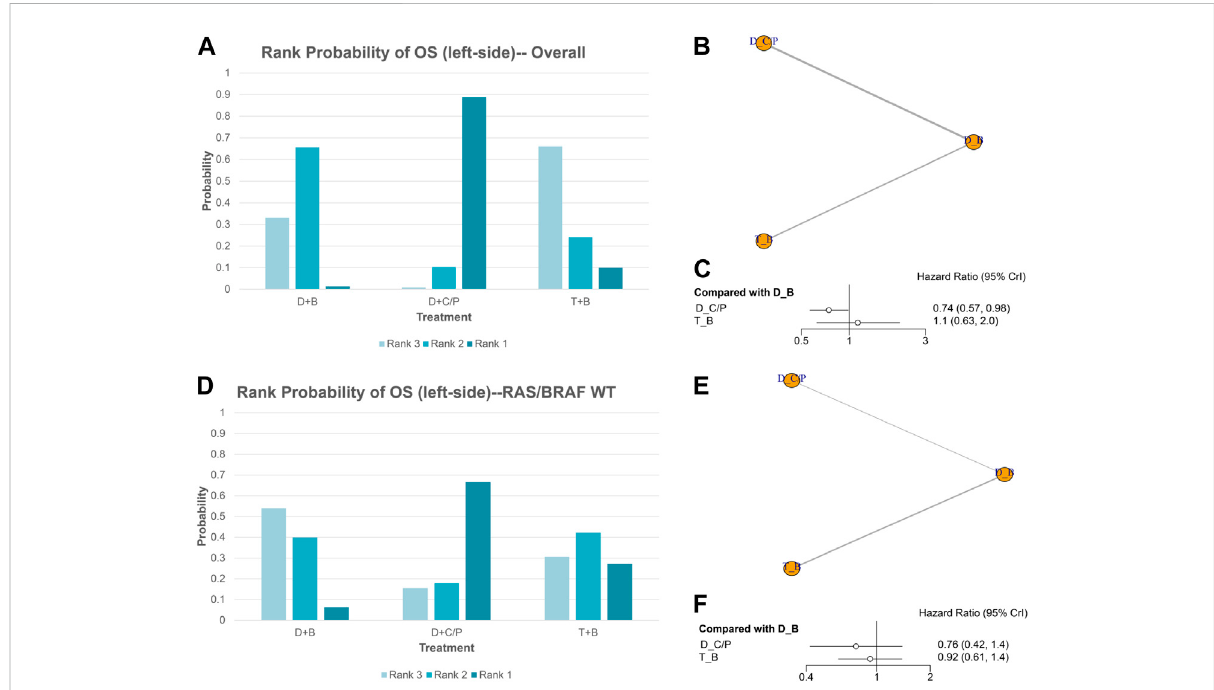
FIGURE 1 Overall survival (OS) in overall and the subgroup of RAS/BRAF wild-type patients. Overall: (A) The rank probability of the bene fi ts of the treatments. (B) Network of eligible comparisons for network meta-analysis. (C) Forest plot of comparisons to double-drug regimen plus bevacizumab. RAS/BRAF WT: (D) The rank probability of the bene fi ts of the treatments. (E) Network of eligible comparisons for network meta- analysis. (F) Forest plot of comparisons to double-drug regimen plus bevacizumab. ( N = 1925, B: bevacizumab; C: cetuximab; D: double-drug; P: panitumumab; T: triple-drug.)